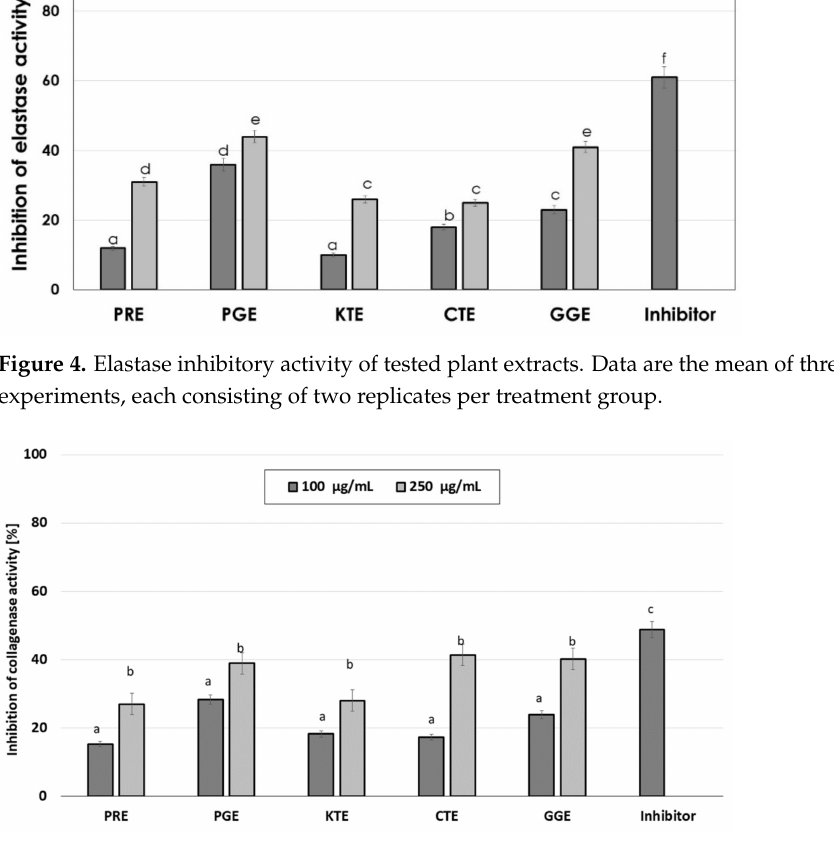
Figure 5. Collagenase inhibitory activity of tested plant extracts. Data are the mean of three indepen- dent experiments, each consisting of two replicates per treatment